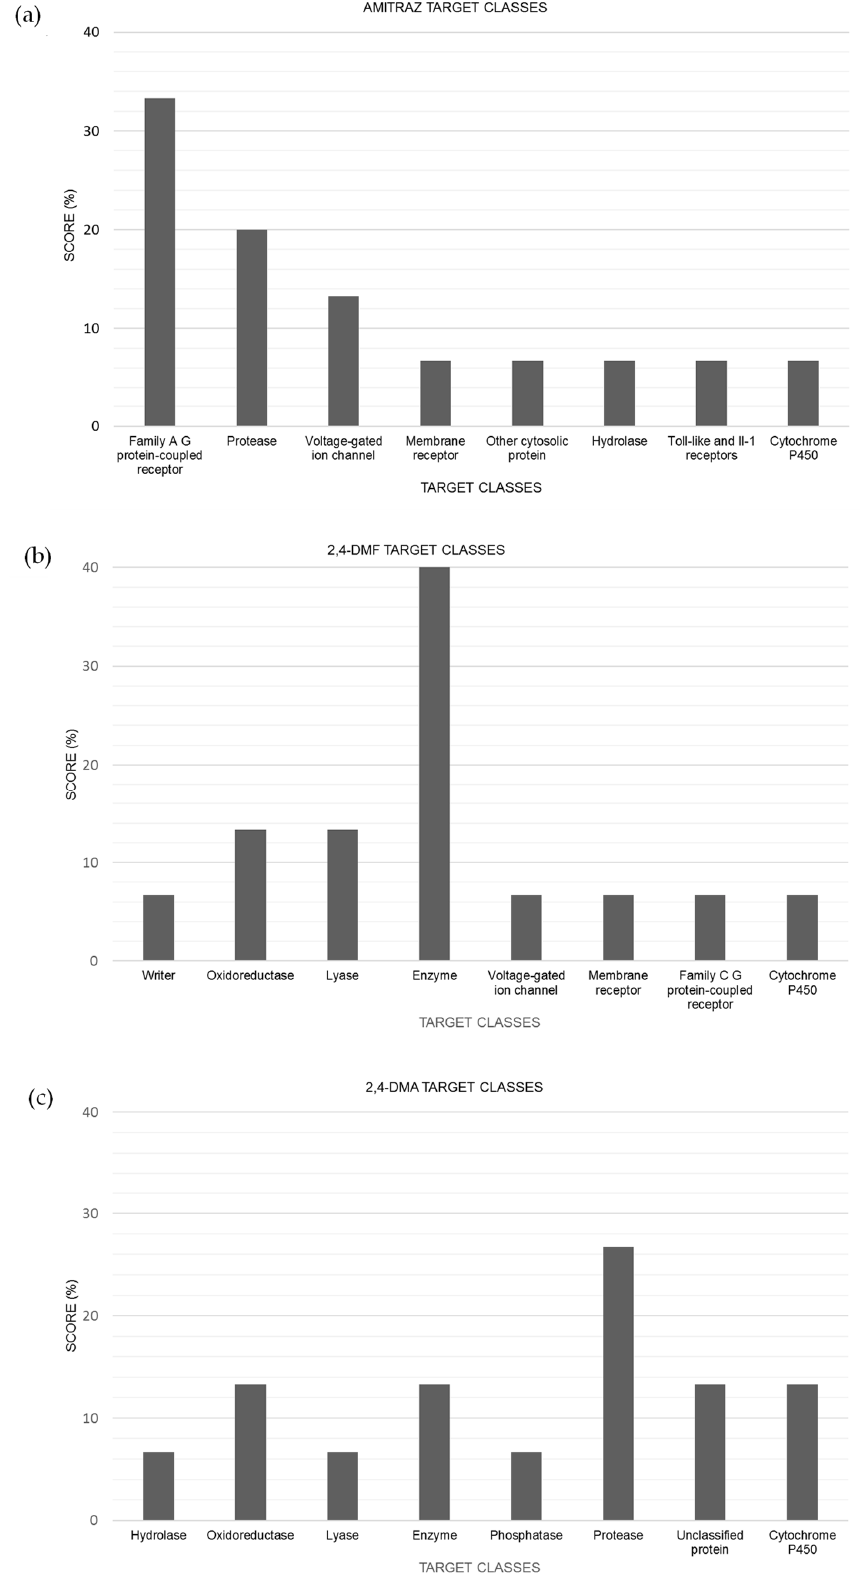
Figure 4. Target classes predicted for ( a ) amitraz, ( b ) 2,4-DMF, and ( c ) 2,4-DMA in “SwissTargetPre- diction”. The graphic shows the percentage of the predicted target classes for analyzed compounds, whose percentages have been calculated using the top 15 predicted targets.